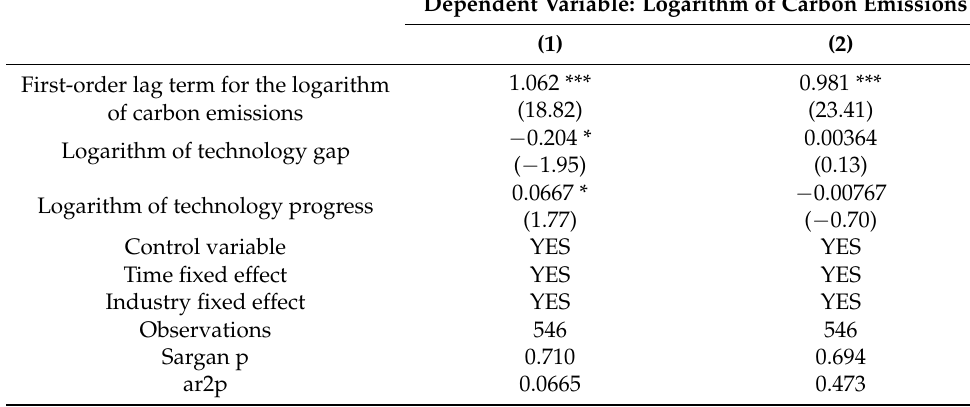
Table 2. Baseline estimation